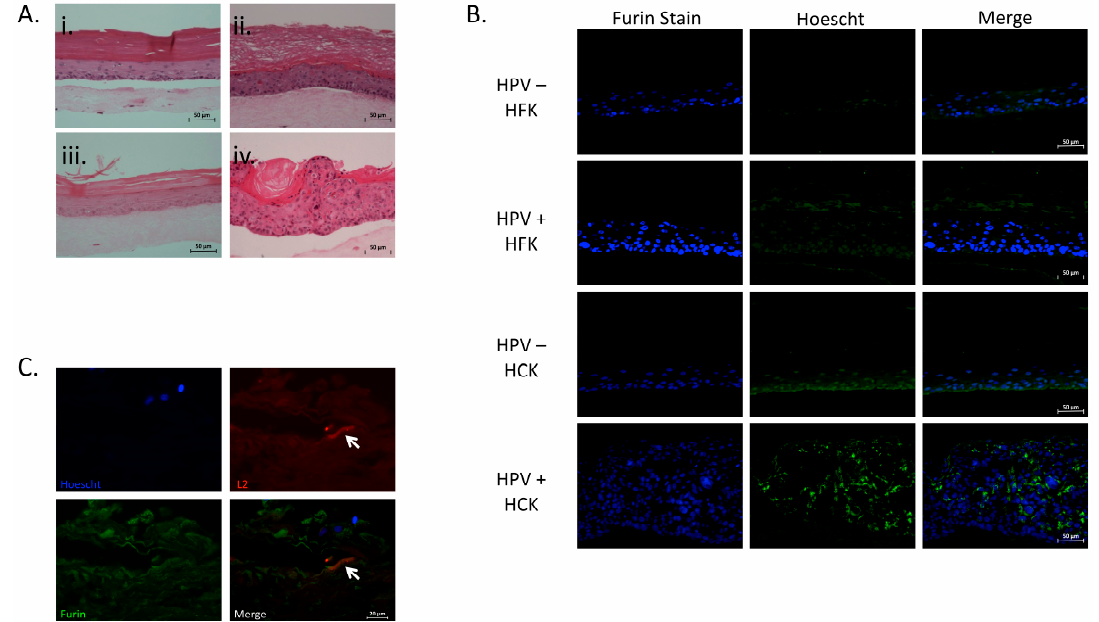
Figure 4. Expression of furin in raft cultures. Hematoxylin and eosin (H&E) staining ( A ) of HPV-negative primary foreskin tissue (i), HPV16-positive foreskin tissue (ii), HPV-negative primary cervical tissue (iii), and HPV16-positive cervical tissue (iv); Immunofluorescent staining ( B ) using the furin (MON-148) antibody of HPV-negative primary foreskin tissue ( top row ), HPV16-positive foreskin tissue ( top-middle row ), HPV-negative primary cervical tissue ( bottom-middle row ), and HPV16-positive cervical tissue ( bottom row ). Nuclear stain was done using Hoechst 33342. Furin stain ( green ). Nuclear stain ( blue ). HPV16-positive foreskin tissue co-stained with furin (MON 148) and L2 (RG-1) antibody ( C ). Nuclear stain was done using Hoechst 33342. Furin stain ( green ). L2 stain ( red ). Nuclear stain ( blue ). White arrows indicate L2 positive cells. Sections were harvested from tissues grown for 20 days in organotypic raft cultures. All images are representative of two sets of staining in two individual sets of rafts.